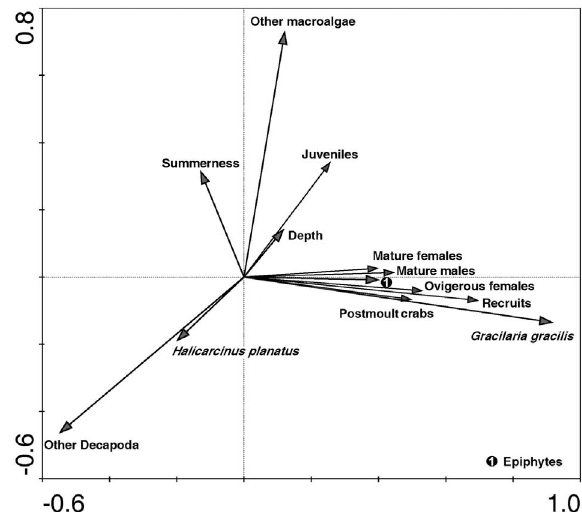
Fig. 8. – Partial redundancy analysis ordination for biological and environmental variables affecting Leucippa pentagona